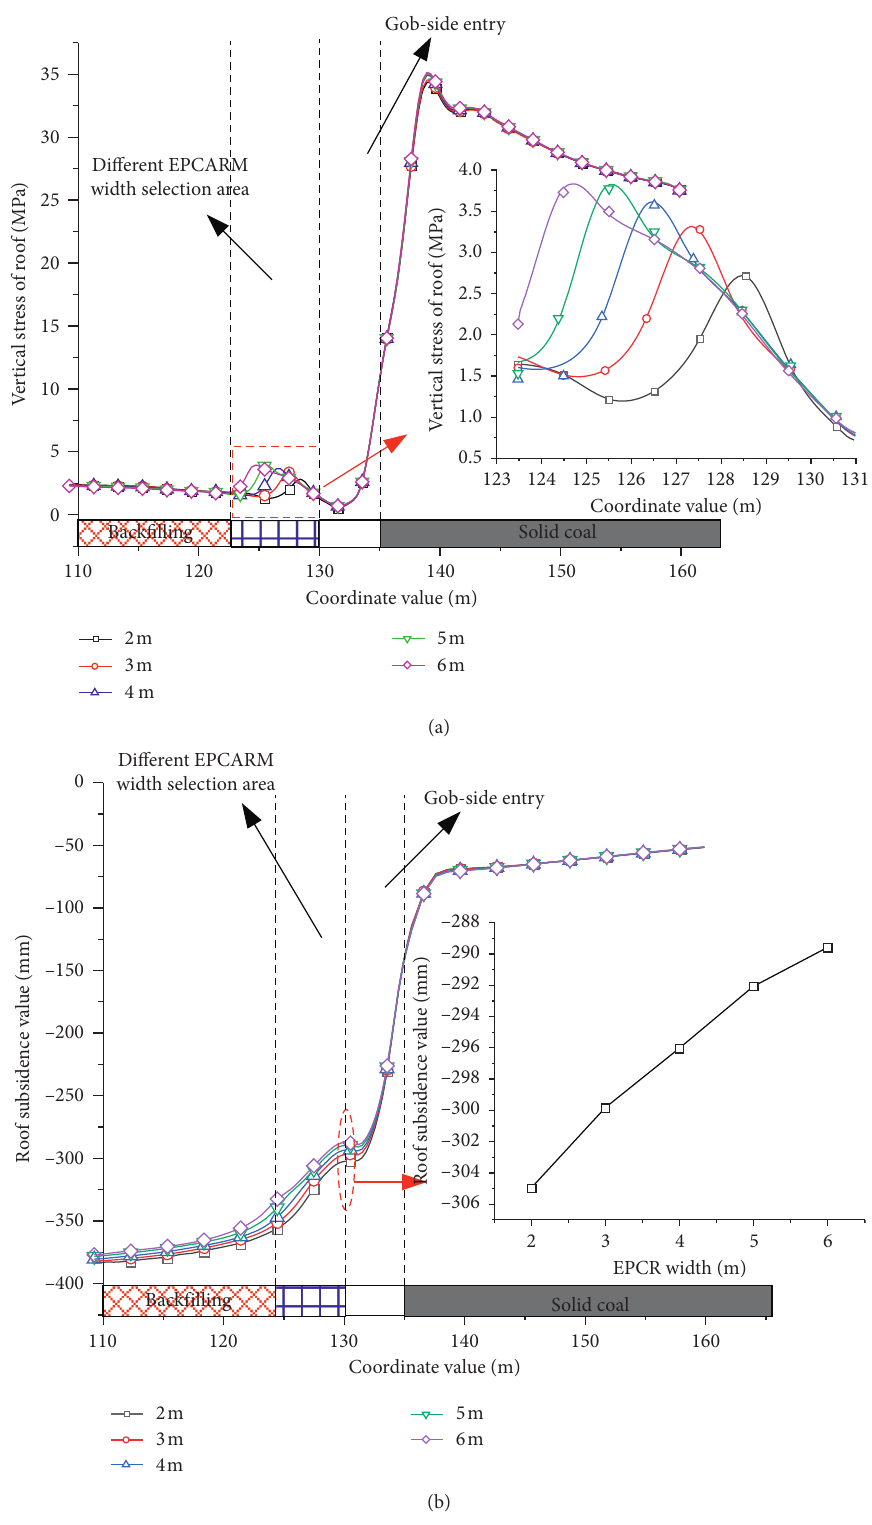
Figure 7: Roof deformation and stress variation for different widths of EPCARM. (a) Stress law. (b) Deformation